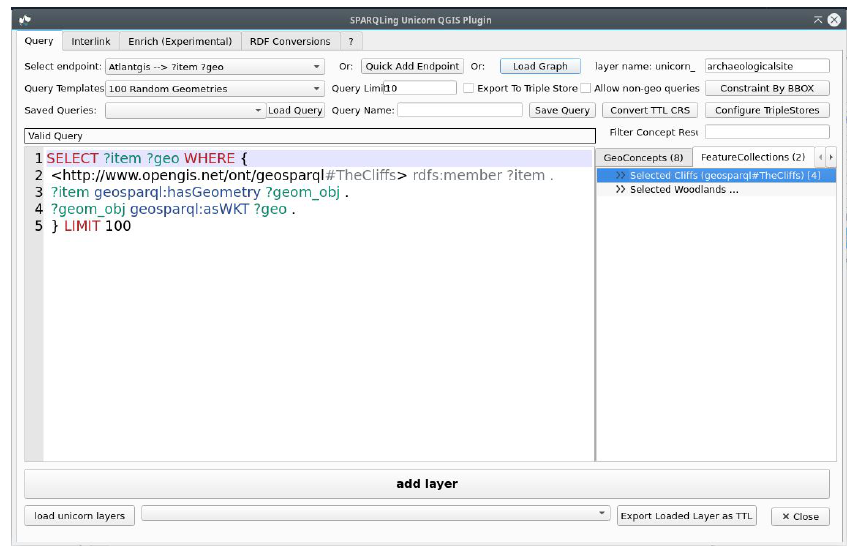
Figure 7. The SPARQL Unicorn QGIS Plugin extended with support for FeatureCollections and GeometryCollections as defined in GeoSPARQL